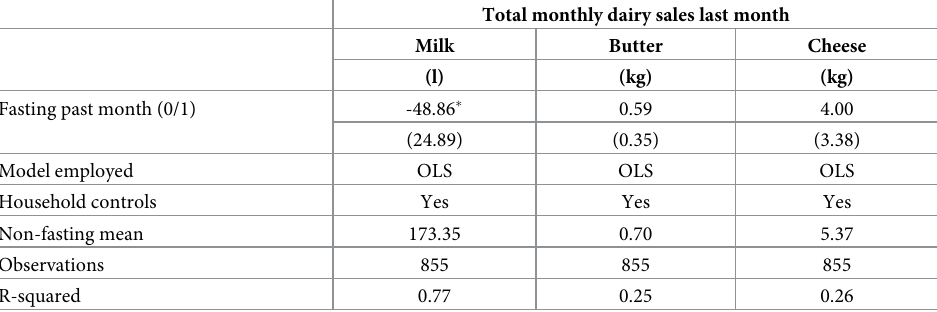
Table 8. Effect of the presence of a long fasting season in the last month on total dairy sales one month prior to the